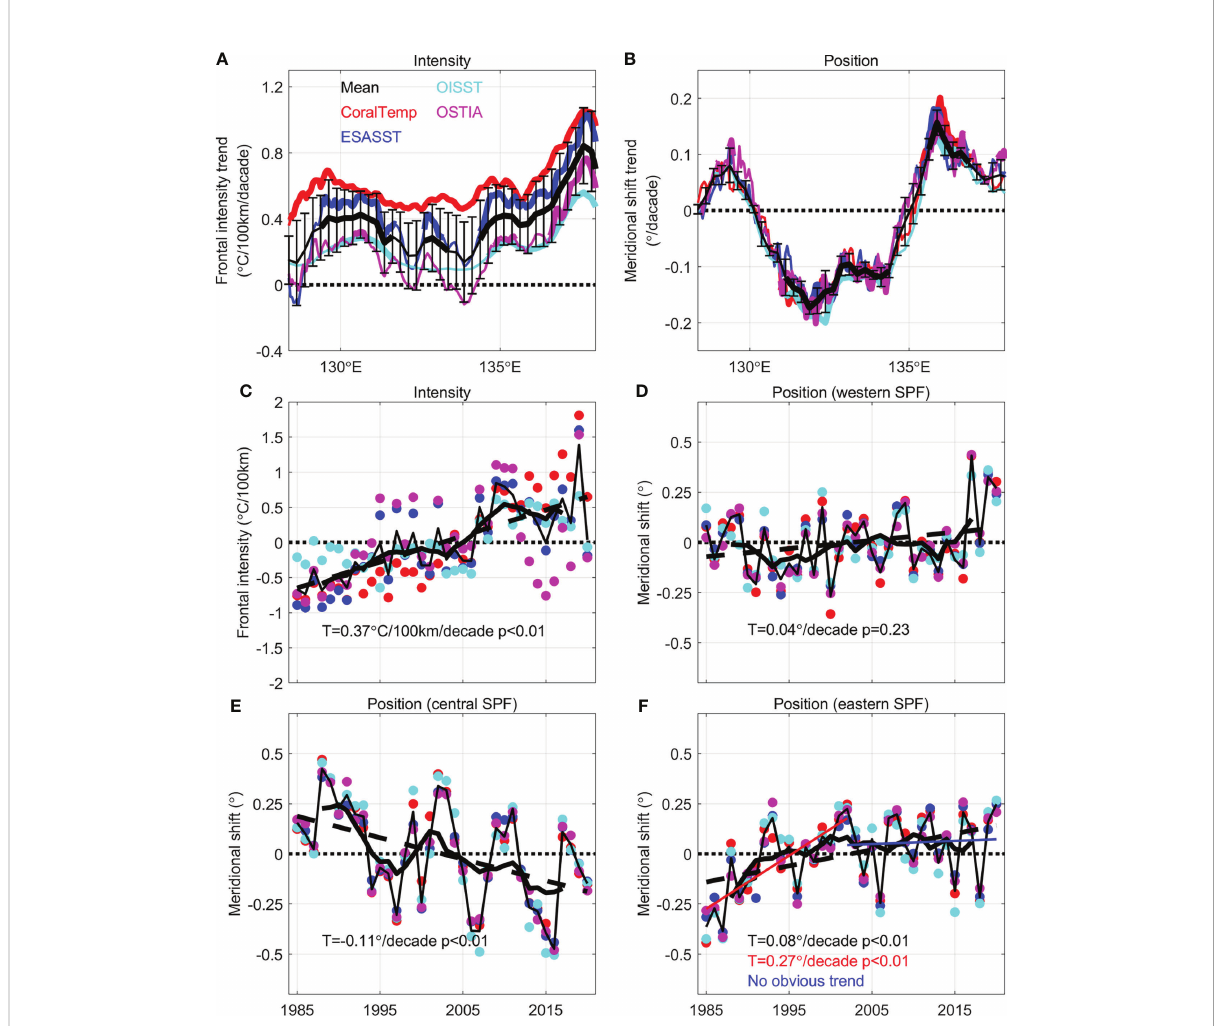
FIGURE 3 Zonal distribution of linear trends for (A) intensity (unit: °C/100km/decade) and (B) position (°/decade) of the SPF. Black, red, blue, cyan, and magenta solid lines are the results of mean, CoralTemp, ESASST, OISST and OSTIA, respectively, and thicker lines indicate statistical signi fi cance passing 95% con fi dence level. Error bars are the standard deviation among four SST datasets. (C) Time series of annual mean intensity (°C/ 100km) of the SPF. Red, blue, cyan and magenta solid dots represent results from four SST datasets as in (A, B) . Black solid lines represent multidata mean (thin line) and seven-year running averages (thick line). Black dashed line indicates linear trend. (D-F) Same as (C) but for annual mean positions for (D) western SPF, (E) central SPF and (F) eastern SPF. The corresponding linear trends (T) are given by the text, and the associated p values ( p )re also given based on the Mann-Kendall test. The red and blue lines in (F) indicate the eastern SPF shift trend before and after 2002,